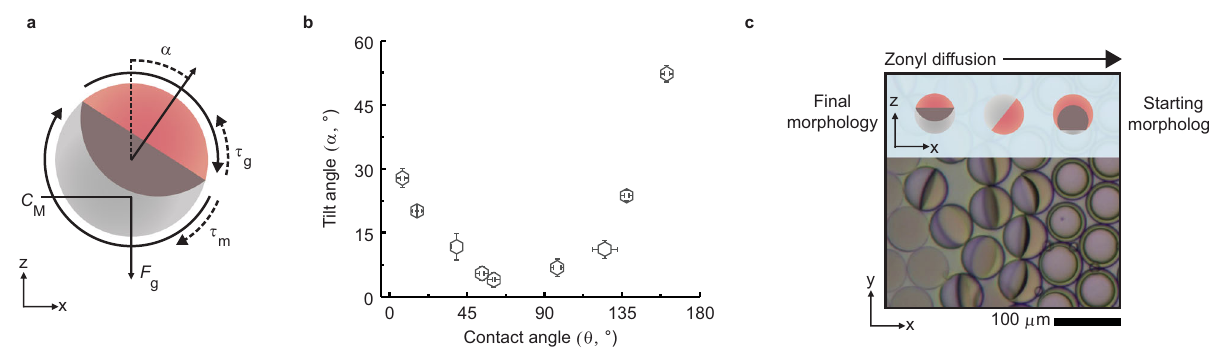
Fig. 4 Janus droplet tilting caused by anisotropic fl uid convections. a Schematic diagram of Janus droplets tilting out of gravitational alignment in response to interfacial tension gradients across their interfaces that result in anisotropic Marangoni-type fl uid convections. The Marangoni fl ow-induced torque τ m is balanced by a gravitational torque τ g due to the force of gravity ( F g ) acting on the center of mass of the droplet ( C M ), generating a tilt off the gravitational axis α ; b experimentally recorded Janus droplet (methoxyper fl uorobutane:decane in AOT:Zonyl) tilting angles as a function of droplet morphology for Janus droplets inside a laminar surfactant gradient evoked by the addition of a 1 wt. % AOT solution to the microchannel, error bars denote > 5 measurements; c Inverted optical micrograph of a monolayer of monodisperse Janus emulsion droplets, originally stabilized by a 1 wt. % SDS:Zonyl (2.5:7.5) solution as a pure 1 wt. % Zonyl solution diffuses through